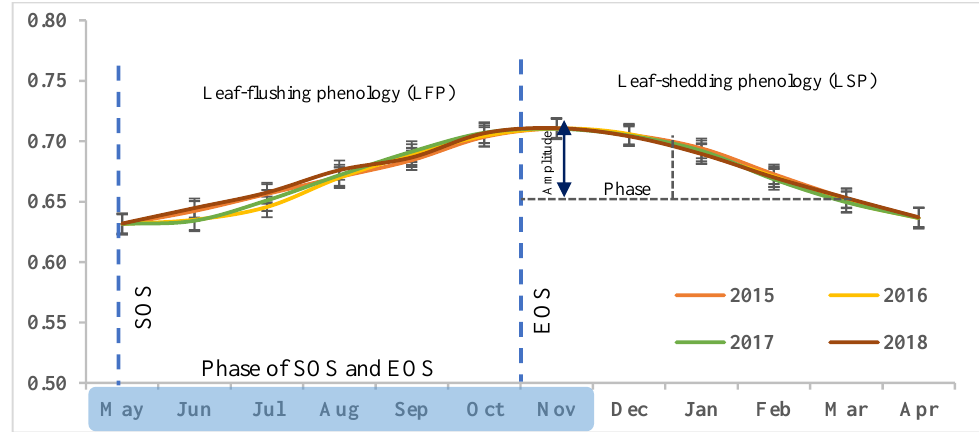
Figure 8. Fitted EVI profile of Landsat 8 OLI EVI composite data for evergreen forest. The average vegetation index profiles were generated from 10 geometry locations by assessing 40 profiles from 2015 to 2018.